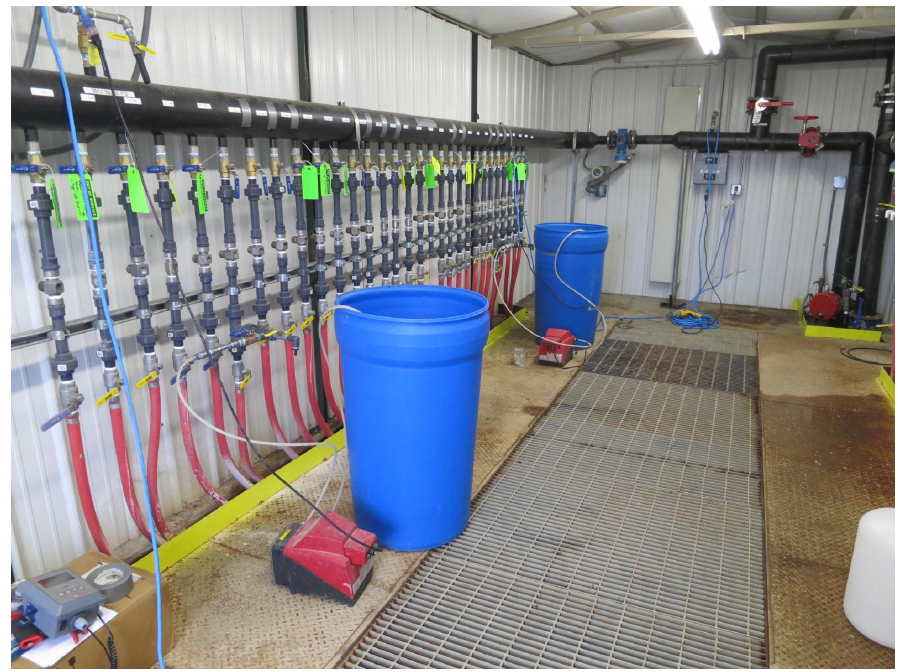
Figure A2. Two tracers being injected from 55-gallon drums into injection wells using high-pressure peristaltic pumps (red units on the floor) in HH 4-11. Table A6. Times of tracer injections into each injection well.